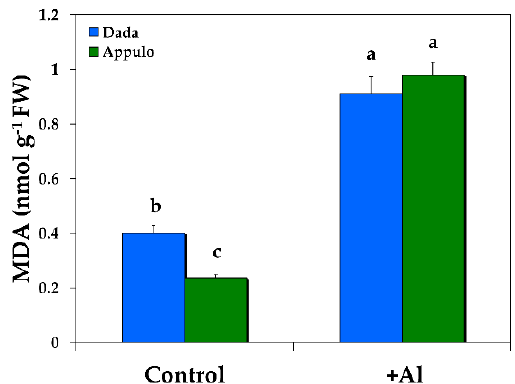
Figure 6. Changes in the level of lipid peroxidation measured as malondialdehyde (MDA) content and expressed as nmol (MDA) g − 1 fresh weight in the triticale ‘Dada’ and the durum wheat ‘Appulo E’, under normal growth conditions (control) and under Al 3+ exposure (+Al). Error bars on columns are standard deviations based on five leaves from five plants. Columns with different letters are statistically different ( p < 0.05).